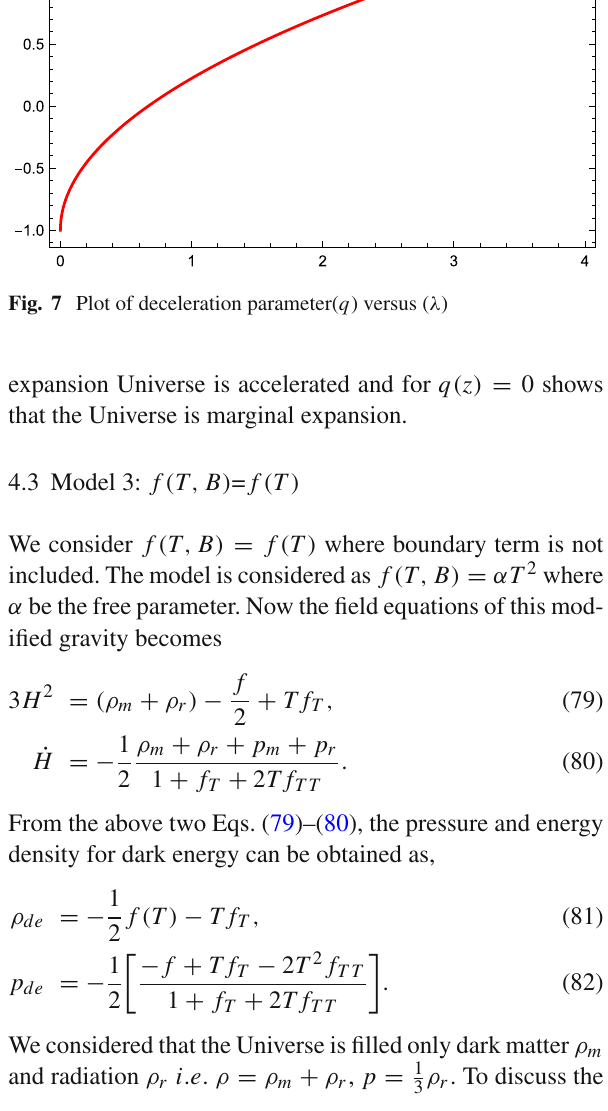
expansion for λ = 2 and z = 1 . For these points ( A 2 , C 2 ) 3 3 three eigenvalues M 1 , M 2 and M 4 are negative and one eigen- value M 3 is positive. Due to the presence of positive and negative eigenvalues, the behavior of critical points ( A 2 , C 2 ) are unstable saddle points. In second plot, the trajectories for critical points B 2 and D 2 move towards to the fixed points.